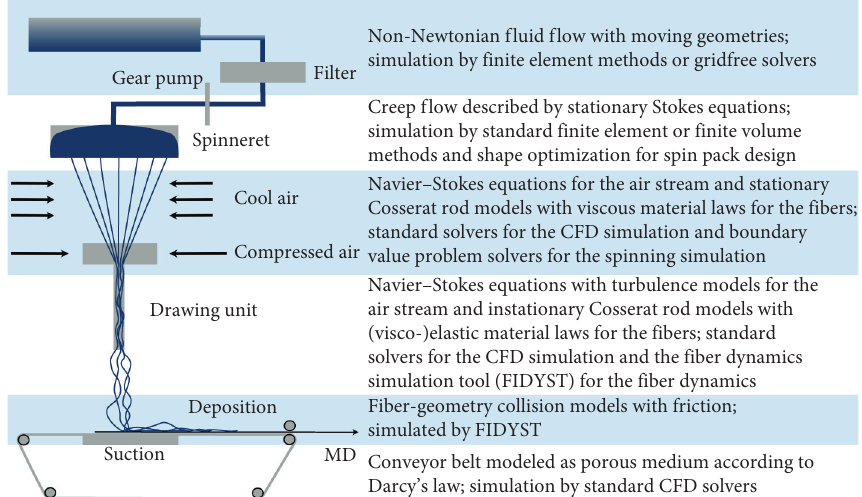
Figure 1: Sketch of a spunbond process with physical models for single process steps; the enumeration of the mentioned simulation methods is not complete but should be understood as examples.